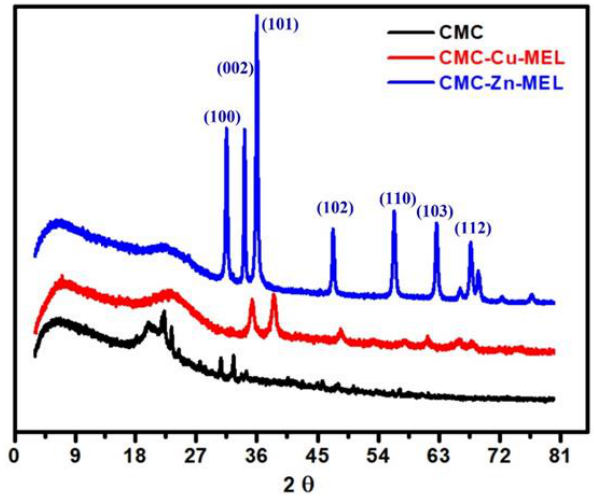
Figure 4. XRD analysis of CMC, CMC-Cu-MEL, and CMC-Zn-MEL.